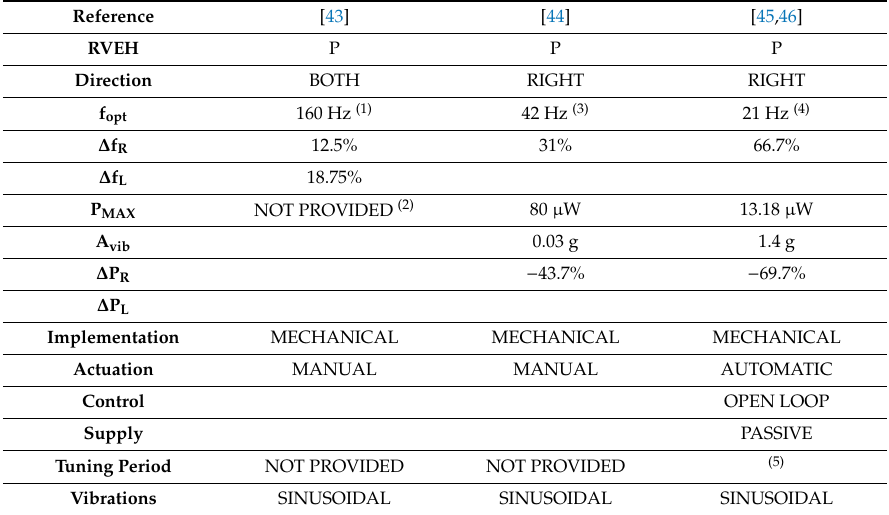
Figure 25. Schematic representation of the variable center of gravity based MTT proposed in [45,46]. A summary of the described variable center of gravity based MTTs is reported in Table 7. Table 7. Variable center of gravity based MTTs classification indicators.